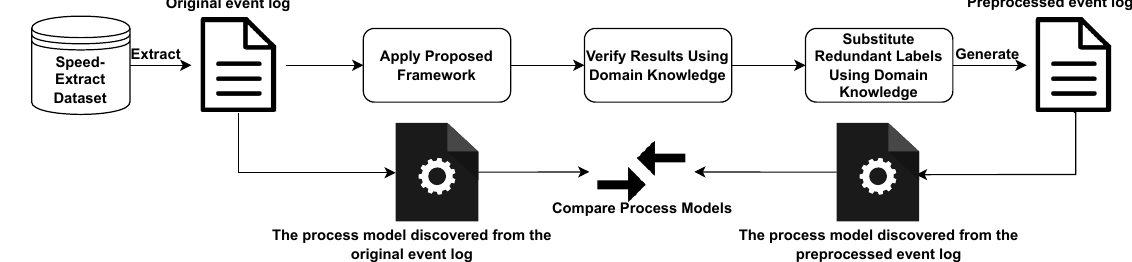
Figure 9. Overview of the case study